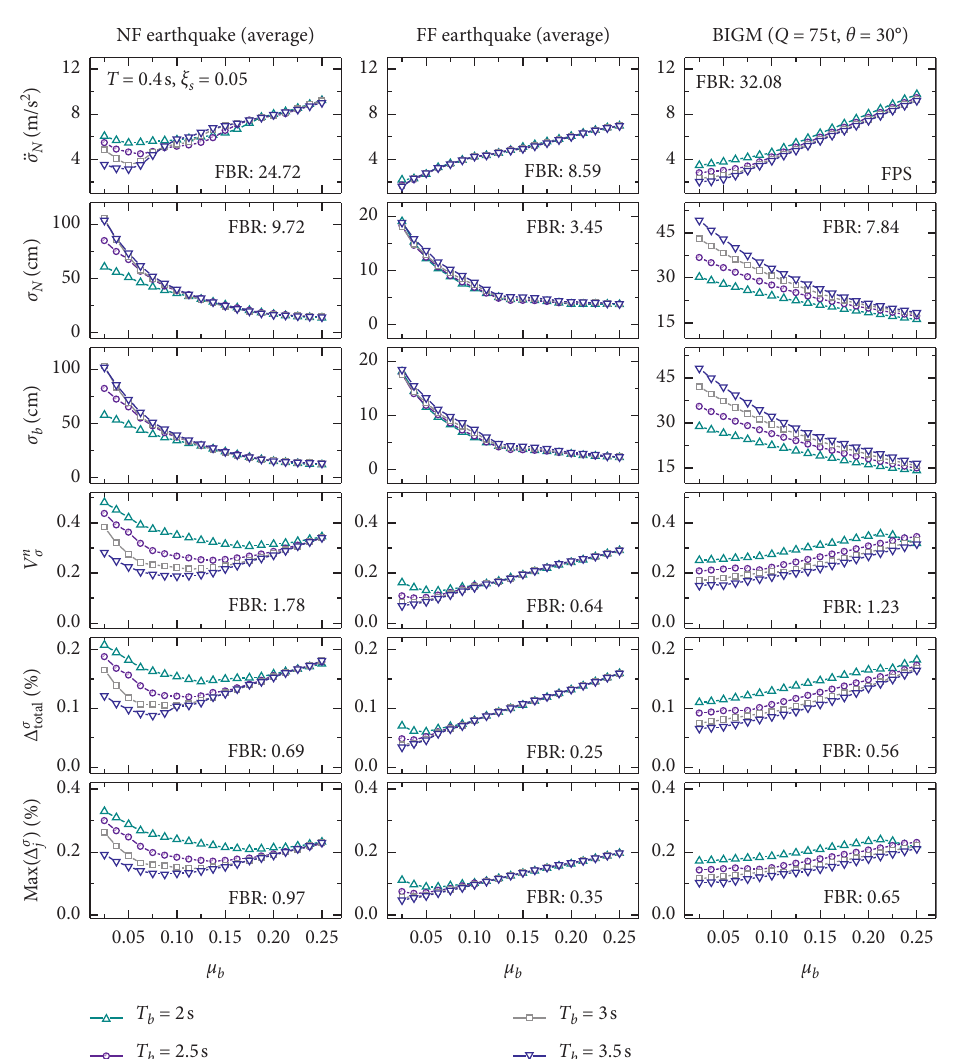
Figure 12: The effect of the friction coefficient of the isolator ( μ isolated by the FPS under earthquake and BIGM.